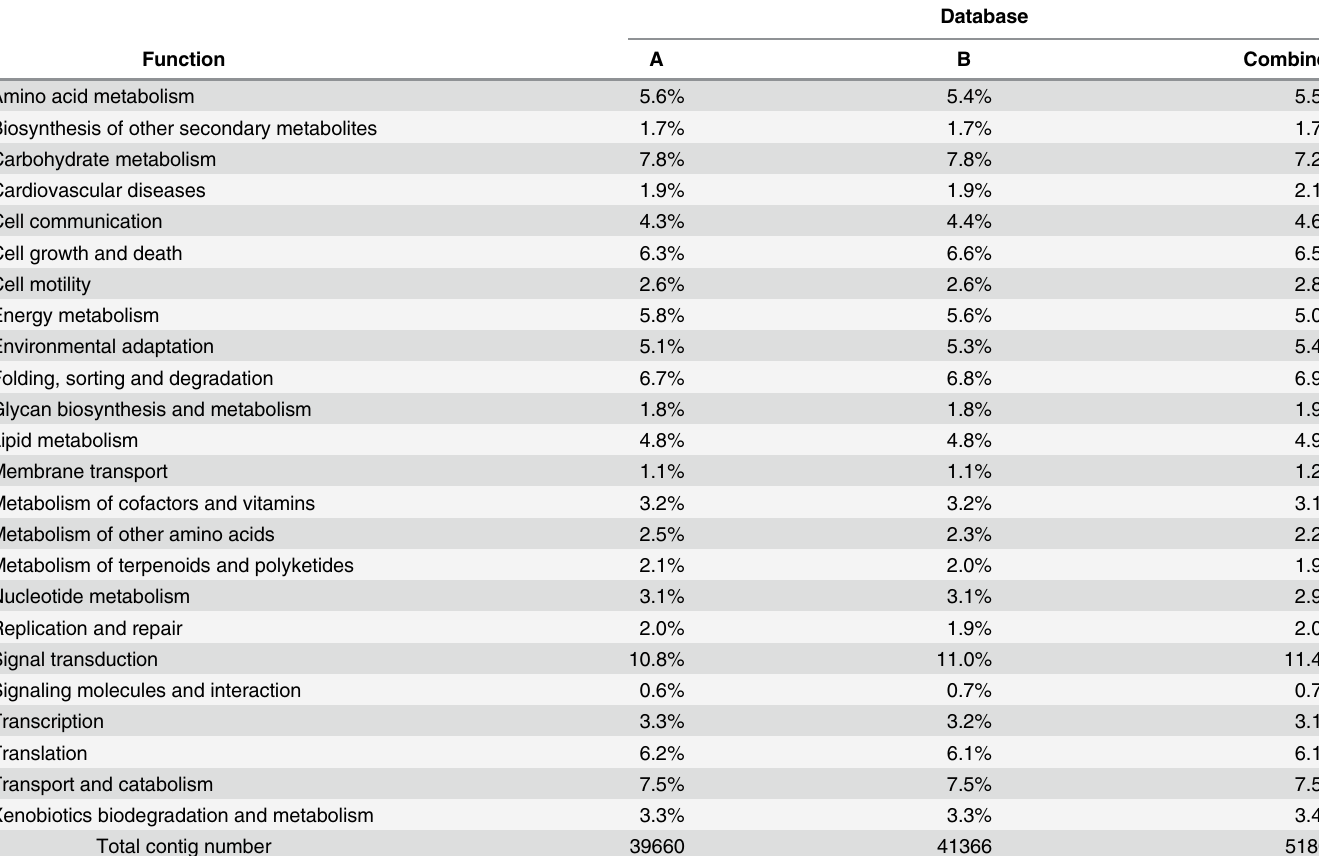
Table 3. The KEGG functional distributions of contigs in each